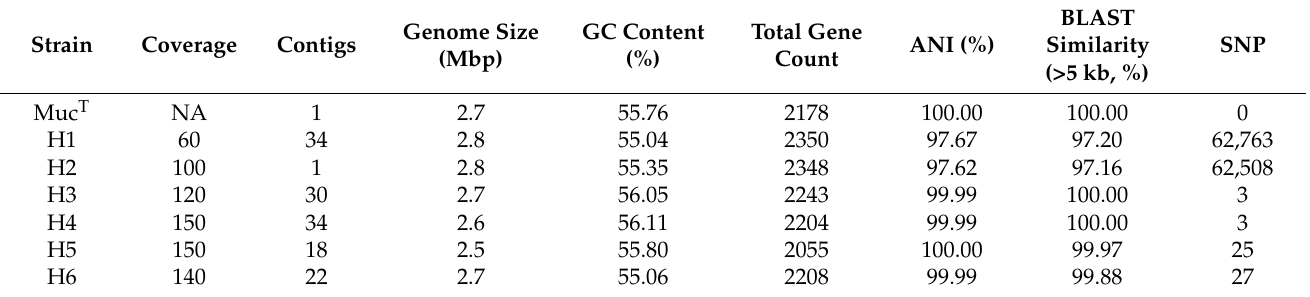
Table 1. Sequence characteristics of the new A. muciniphila isolates and comparison to genome of the type-strain Muc T (ANI, BLAST similarity and